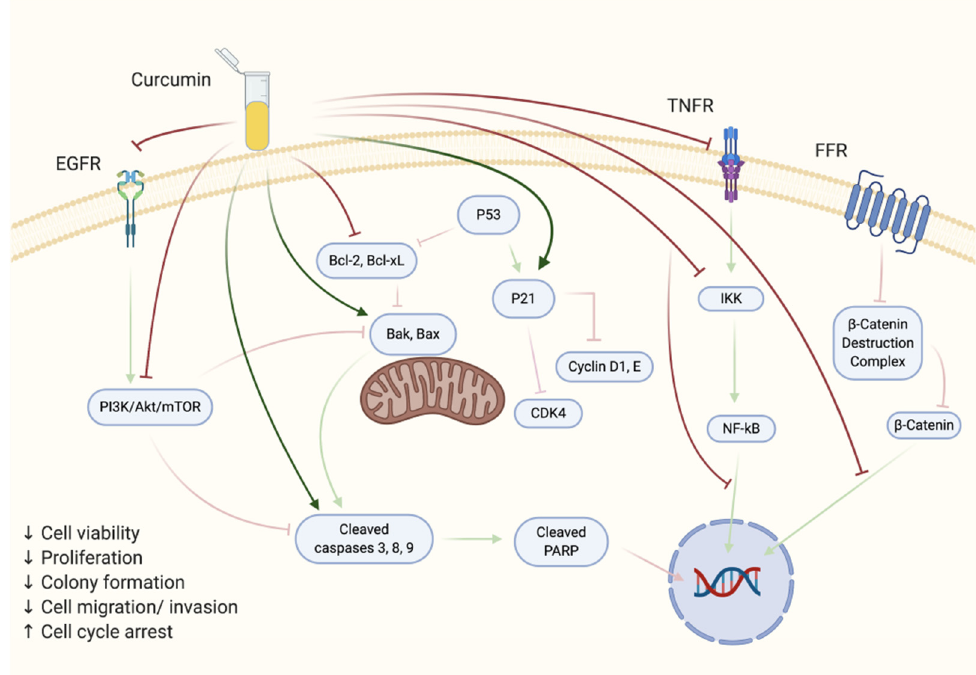
Figure 3. Effects of curcumin treatment on prostate cancer cells in vitro. The figure is based on the data of the studies [54–68] and created using BioRender.com. Table 3. In vitro evidence of the effects of curcumin on androgen-sensitive prostate cancer cells. Cell Line Curcumin Dosage